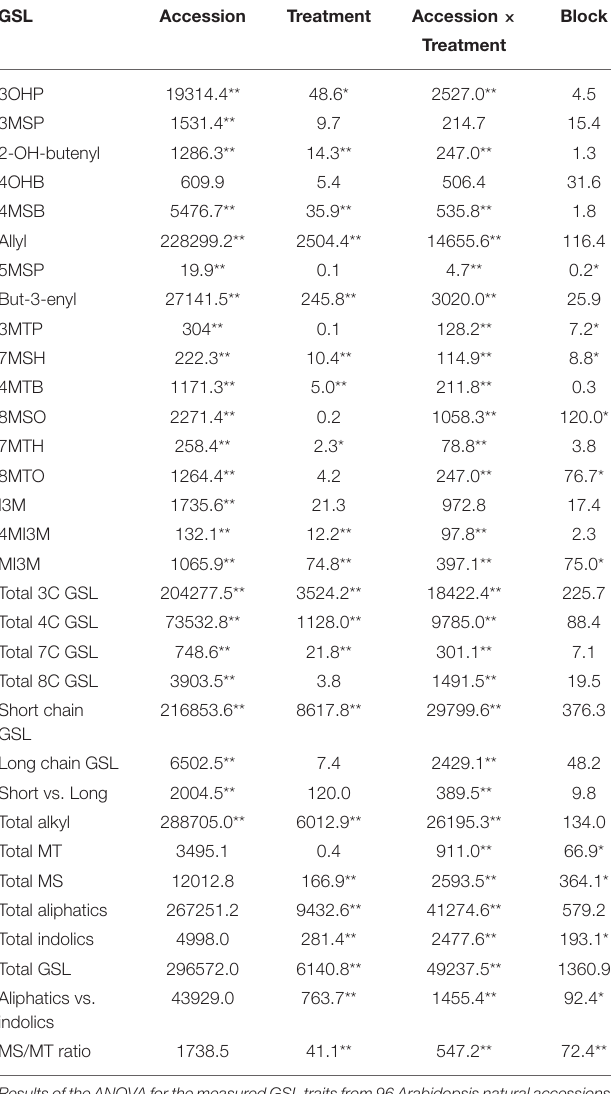
TABLE 3 | Allyl treatment affects Arabidopsis GSL